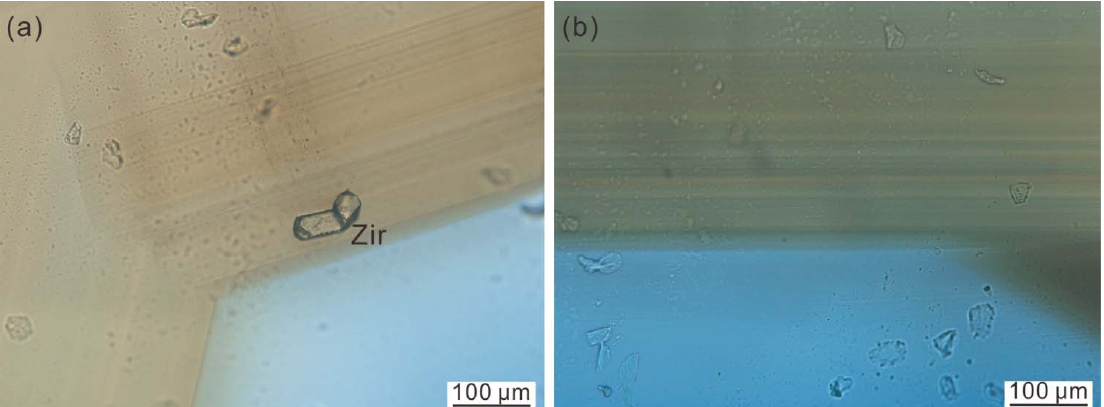
Figure 5. ( a,b ) Photographs of the Penglai sapphire (sample Sap ‐ 1) showing blue core rimmed by Figure 5. ( a , b ) Photographs of the Penglai sapphire (sample Sap-1) showing blue core rimmed by